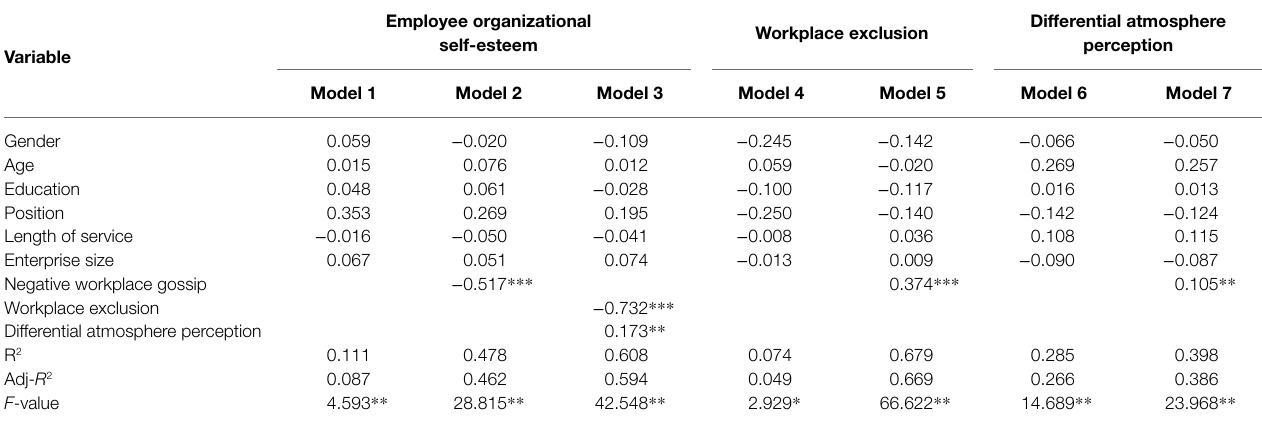
Employee organizational